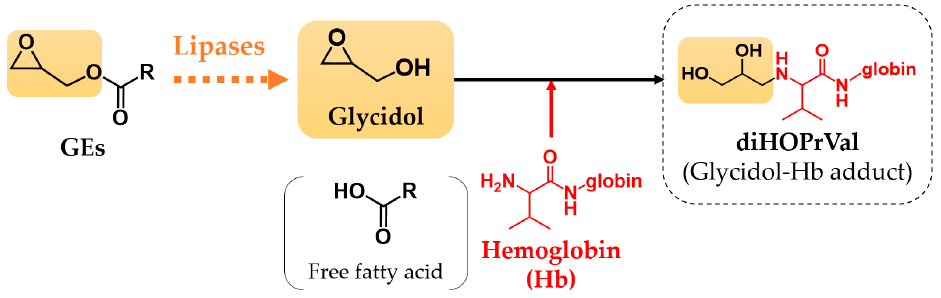
Figure 1. Formation of glycidol from glycidyl fatty acid esters (GEs) and glycidol–hemoglobin adduct